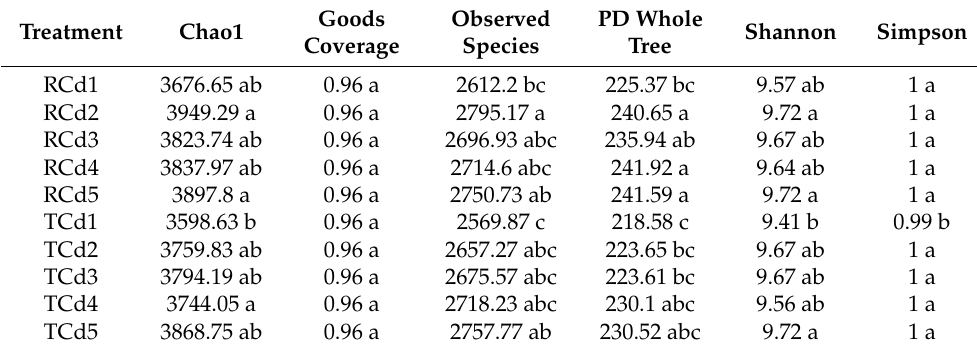
Figure 1. Correlation heatmap of tomato quality with soil physicochemical properties. “*” means the correlation is significant at 0.05 level. “**” means the correlation is significant at 0.01 level. Table 5. Bacterial community diversity indices for different